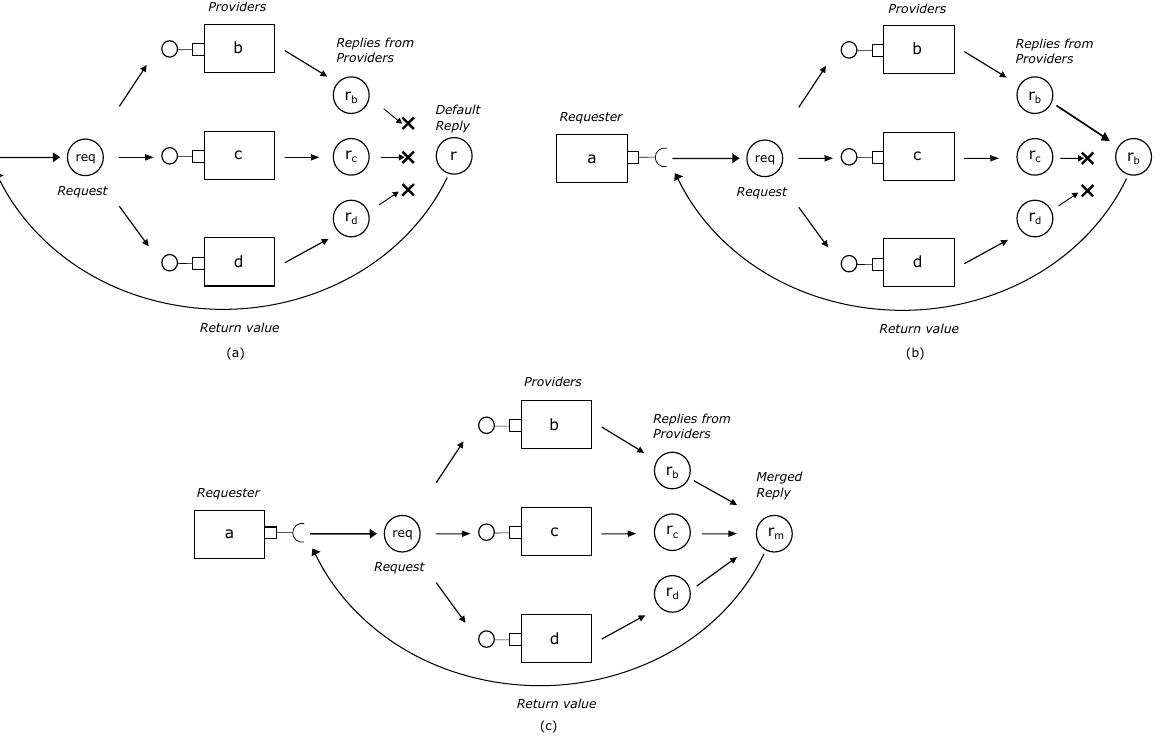
Figure 4. Reply merge strategies for the example case presented in Figure 1: ( a ) Replies from providers are discarded, and a default reply is returned. ( b ) One of the replies is chosen. ( c ) Replies from providers are merged into a single reply.